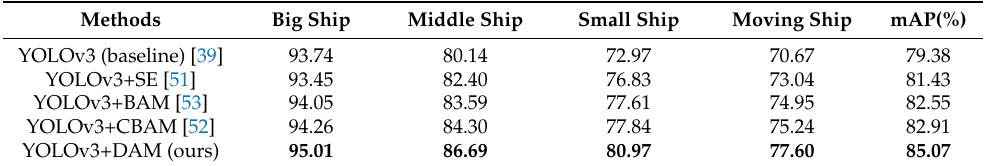
Table 3. The performance of attention modules on ship detection performance. The entries with the best APs for each object category are boldfaced.